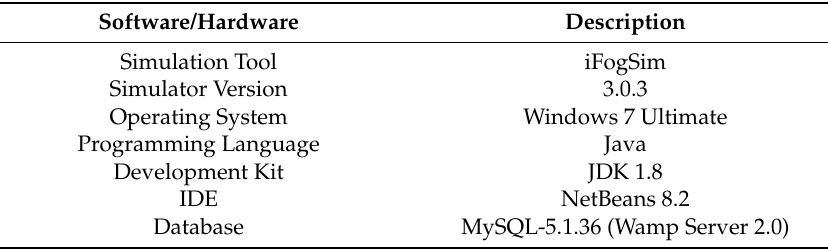
Table 4. Software and Hardware